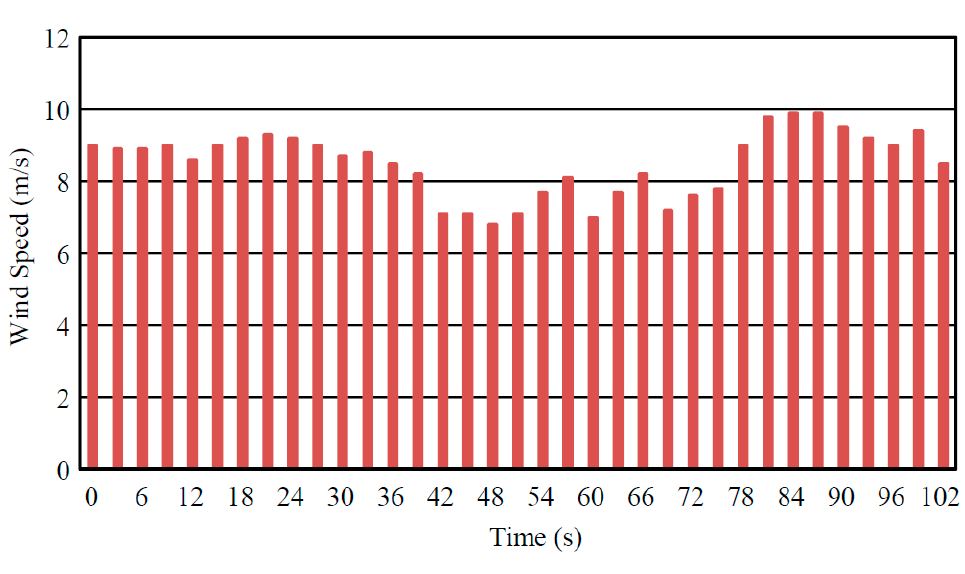
Figure 2. Wind speed profile.